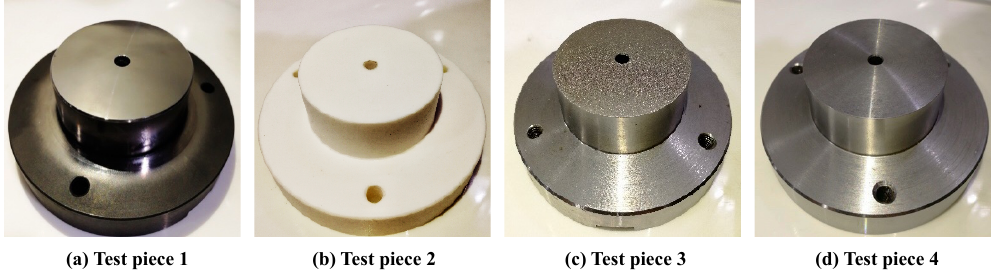
Figure 3. Photographs of the four test pieces: ( a ) Test piece 1; ( b ) Test piece 2; ( c ) Test piece 3; and ( d ) Test piece